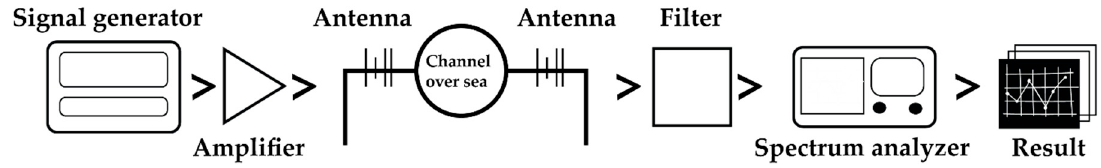
Figure 8. Basic setup for measurements of propagation loss.